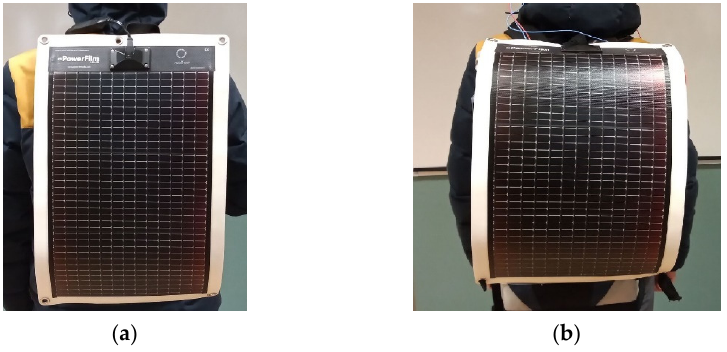
Figure 7. Rollable PV sheet: ( a ) Flat; ( b ) Curved.